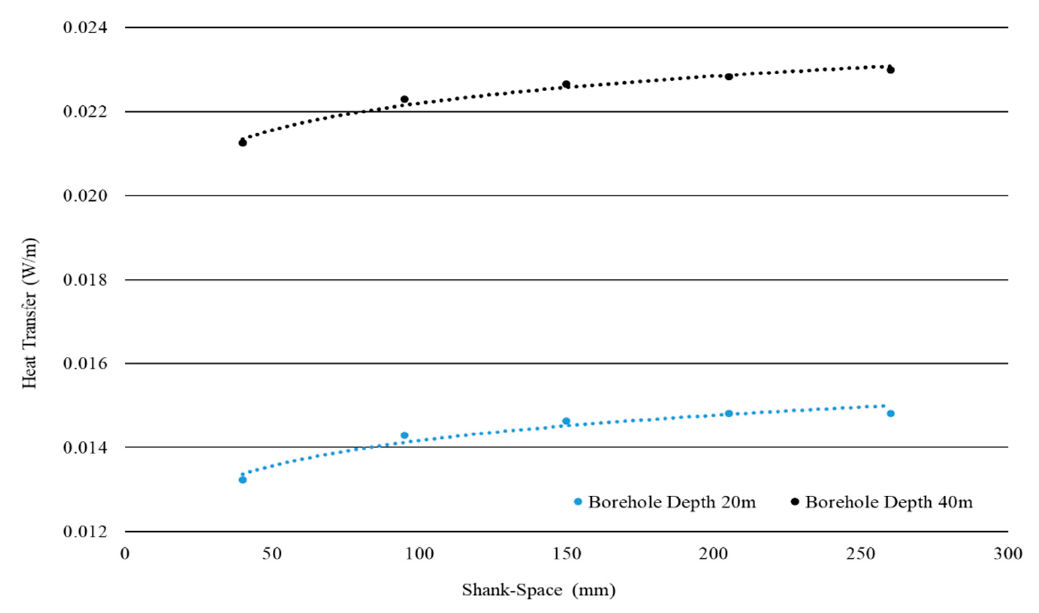
Figure 8. Heat transfer (W / m) for di ff erent shank-spaces for the two borehole depths investigated.